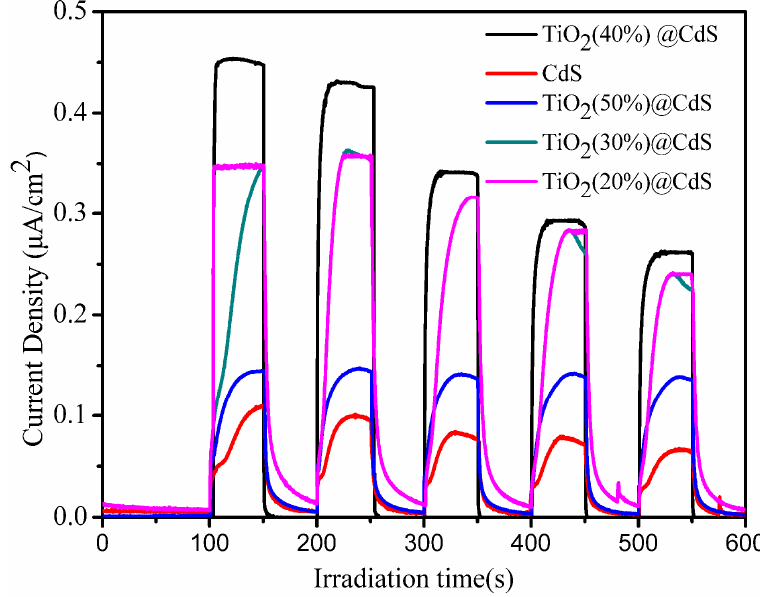
Figure 6. Photocurrent response curve of TiO 2 nanorod–CdS nanoparticle composites.